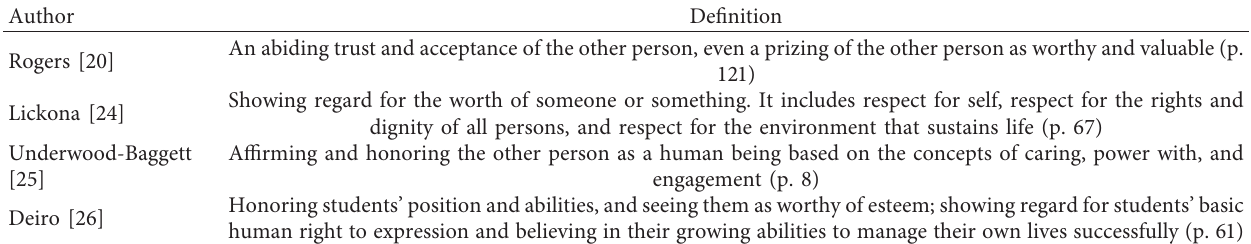
Table 1: Definitions of respect within the psychological and educational literature.